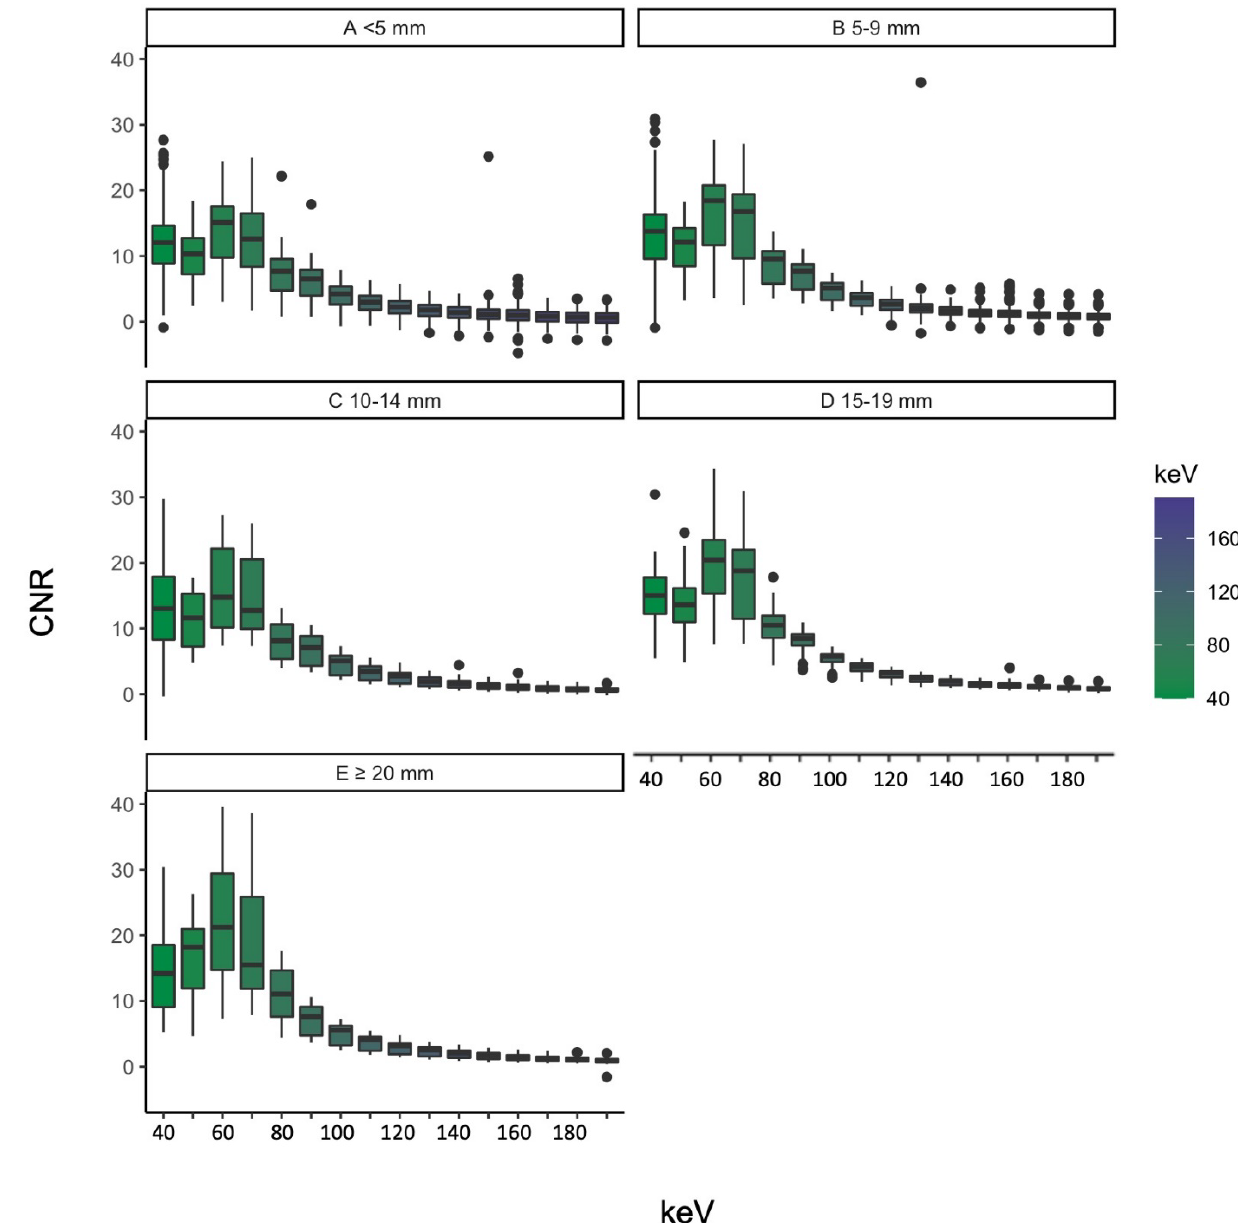
Figure 6. CNR grouped by vessel diameter (( A ) for less than 5 mm, ( B ) for 5–9 mm, ( C ) for 19–14 mm, ( D ) for 15–19mm and ( E ) for more than 20 mm) according to the used energy threshold.